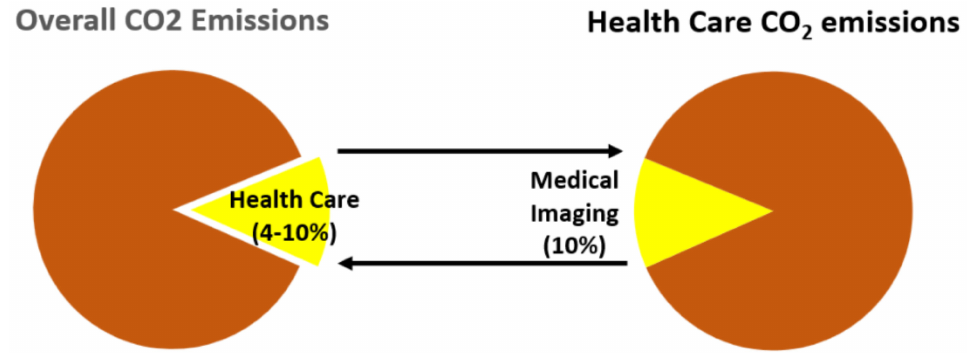
Figure 2. The contribution of healthcare and medical imaging to overall carbon emissions on a planetary